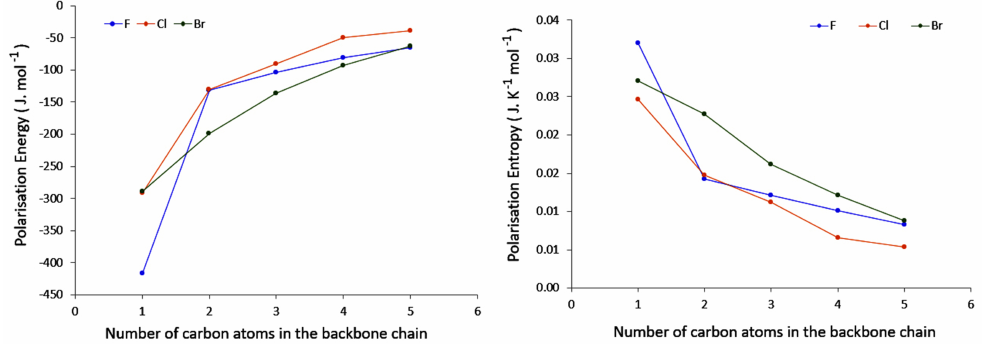
Figure 2. Evolution of the polarisation Energy ( left ) and Entropy ( right ) when the Carbon Neighbour to the Halogen is perturbed with respect to the number of carbon atoms in the backbone